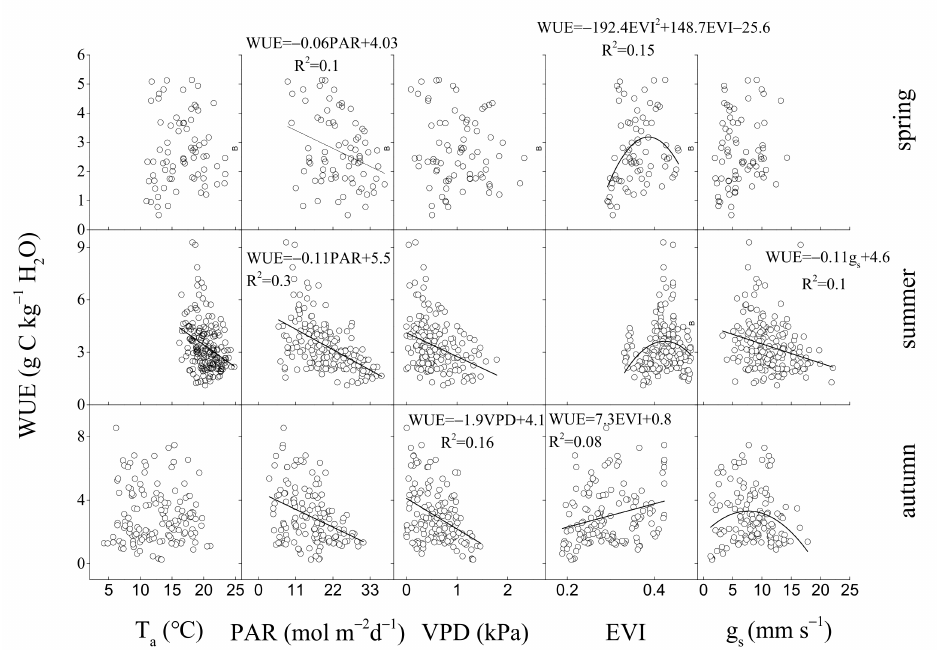
Figure 11. Relationships between daily water use efficiency (WUE) and daily environmental factors (T a , PAR, VPD) and biological factors (EVI, midday g s ) in three seasons (spring, summer, autumn) from 2017 to 2020.